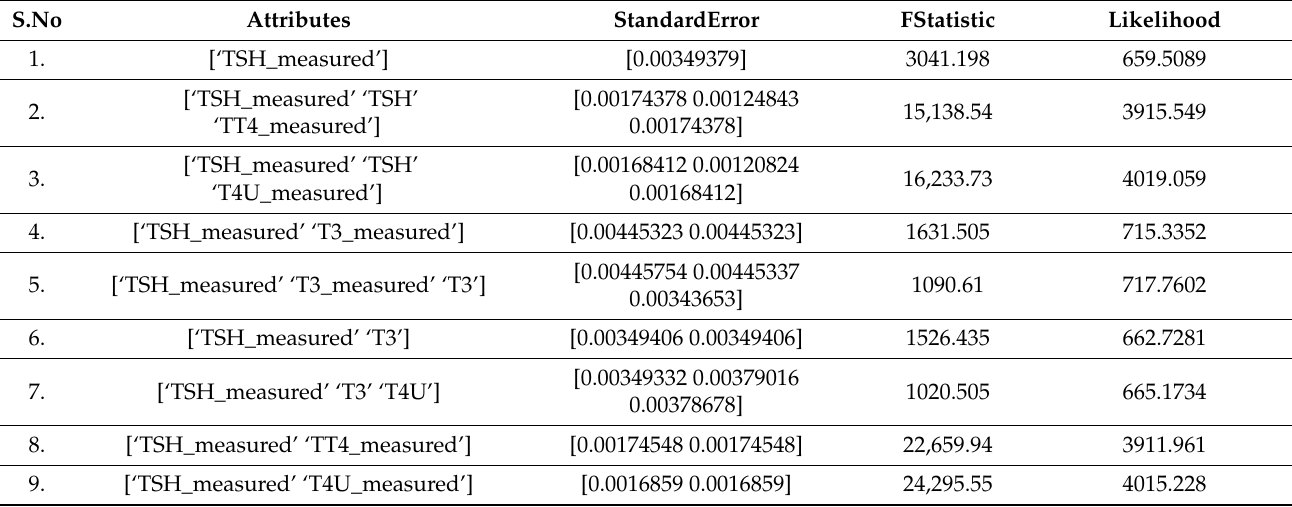
Table 27. OLS features of the significant subset attributes of the hypothyroid